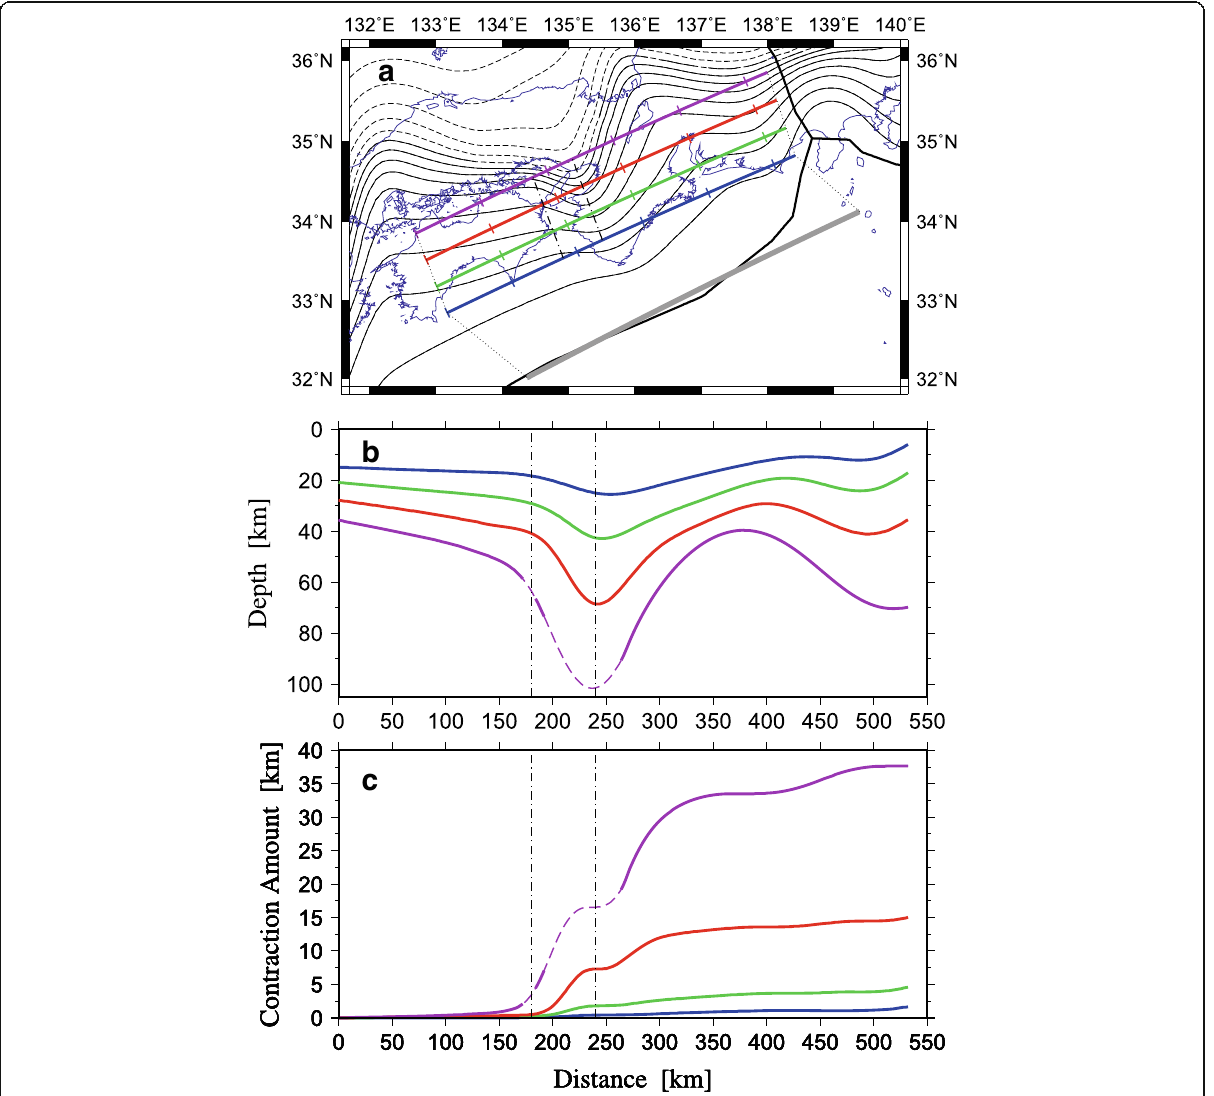
Fig. 2 a Locations of lines used to measure contraction amounts. Blue, green, red, and purple lines on the PHS slab were situated along the Nankai Trough shown by the thick gray line at 3, 4, 5, and 6 Ma, respectively, under the assumption of plate motion (see text). Each colored line has a tick every 100 km. Contour lines of the PHS slab of the CAMP model (Hashimoto et al. 2004) are drawn every 10 km with thin solid lines. The depth data of the CAMP model are extrapolated to the region without data by the “ surface ” command of GMT, the contours of which are drawn by broken lines. Thick solid lines represent the plate boundaries after Bird (2003). The zone bounded by the dot-and-dash lines is the area that is possibly affected by the tear of the PHS slab, in which the depth contours could be significantly altered. b Depth profile of the PHS slab along each colored line. In the region without depth data, the depth profile follows the extrapolation (broken line). The zone bounded by the dot-and-dash lines shows the area that is possibly affected by the tear of the PHS slab. c Contraction amount of the PHS slab along each colored line as a function of the distance from the western end. In the region without depth data, extrapolated data are used to calculate the contraction amount, which is shown by the broken